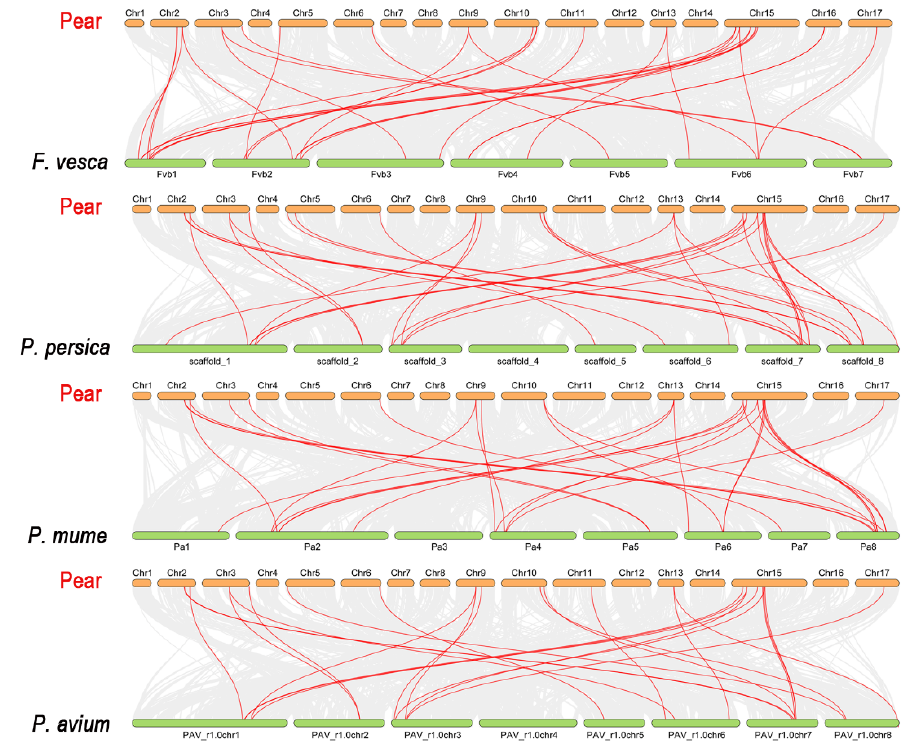
Figure 7. Collinearity analysis of GATA genes family in Pyrus bretschneideri between Fragaria vesca , Prunus persica , Prunus mume , and Prunus avium. The red line represents the collinearity relationship among Rosaceae species.